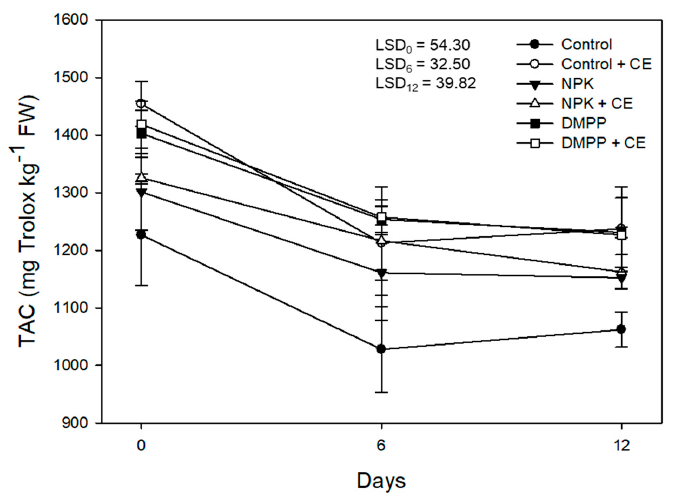
Figure 3. Total antioxidant capacity measured by ferric reducing antioxidant power (FRAP) of fresh spinach leaves at 0, 6, and 12 days of storage at 4 °C. Control; Control + CE, control with compost extract; NPK, inorganic NPK fertilizer 15-15-15; NPK + CE, inorganic NPK with compost extract; DMPP, ENTEC Nitrofoska ® plus the nitrification inhibitor (IN) 3,4-dimethylpyrazole phosphate (DMPP); DMPP + CE, the nitrification inhibitor (IN) with compost extract. Spinach leaves showed a progressive change in color, this effect increasing during storage for several fertilization treatments. At the end of shelf-life, the highest differences in color as regards to the initial values were detected for DMPP and DMPP + CE (Figure 4). That color change was related to higher values of a* and b* for that treatment compared to the others (data not shown) indicating a slight trend towards yellowing. Independently of that, the highest Δ E * values for all the treatments were always below 2. Figure 4. Total color differences ( Δ E*) of fresh spinach leaves with different fertilizer treatment after 6 and 12 days of storage at 4 °C. Control; Control + CE, control with compost extract; NPK, inorganic NPK fertilizer 15-15-15; NPK + CE, inorganic NPK with compost extract; DMPP, ENTEC Nitro- foska ® plus the nitrification inhibitor (IN) 3,4-dimethylpyrazole phosphate (DMPP); DMPP + CE, the nitrification inhibitor (IN) with compost extract.